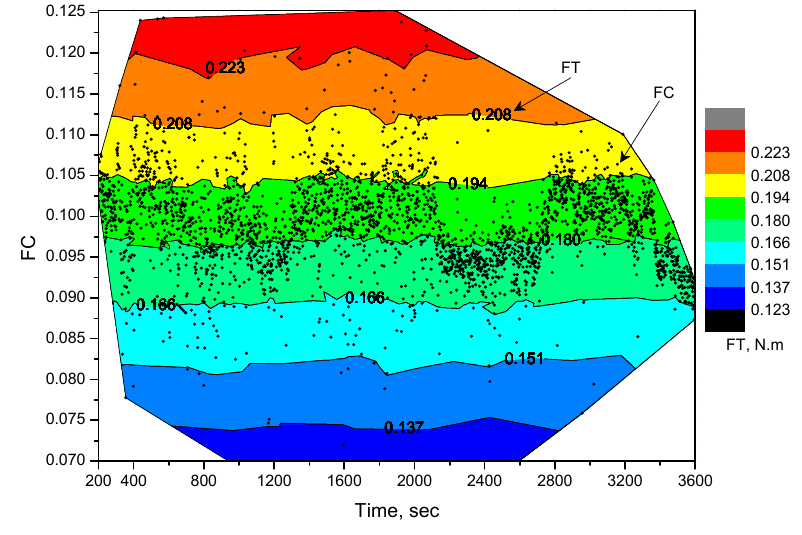
Figure 4. Correlation of friction torque (FT) and FC at steady state conditions for ULSD.